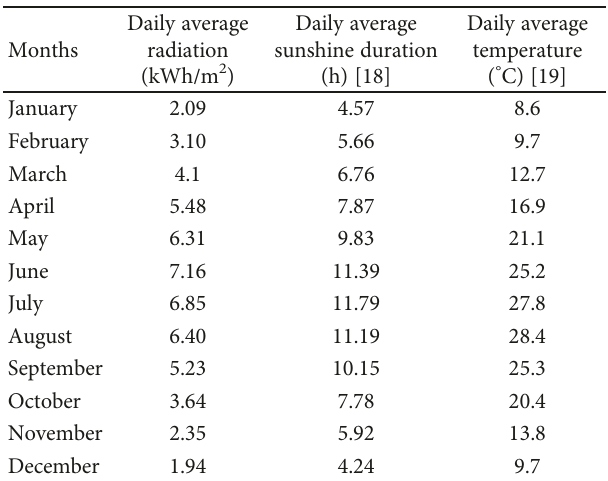
Table 3: The values of daily average measurement